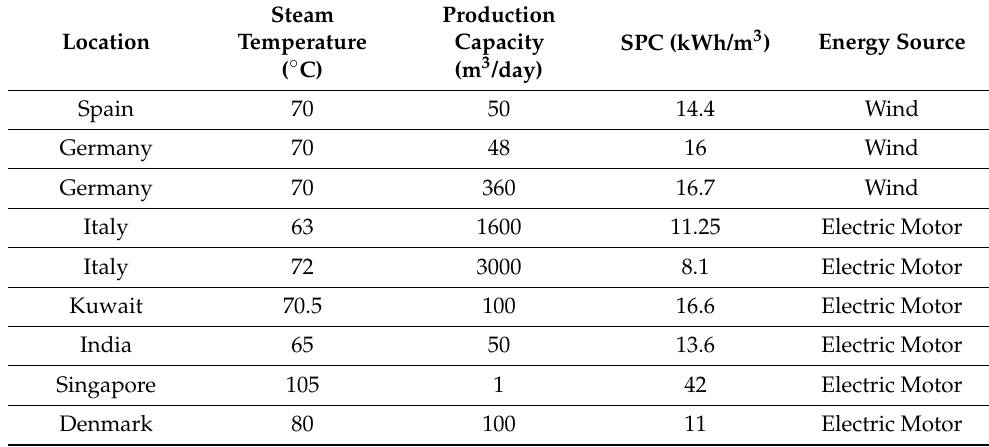
Table 4. Summary of studies conducted on MED–MVC systems.